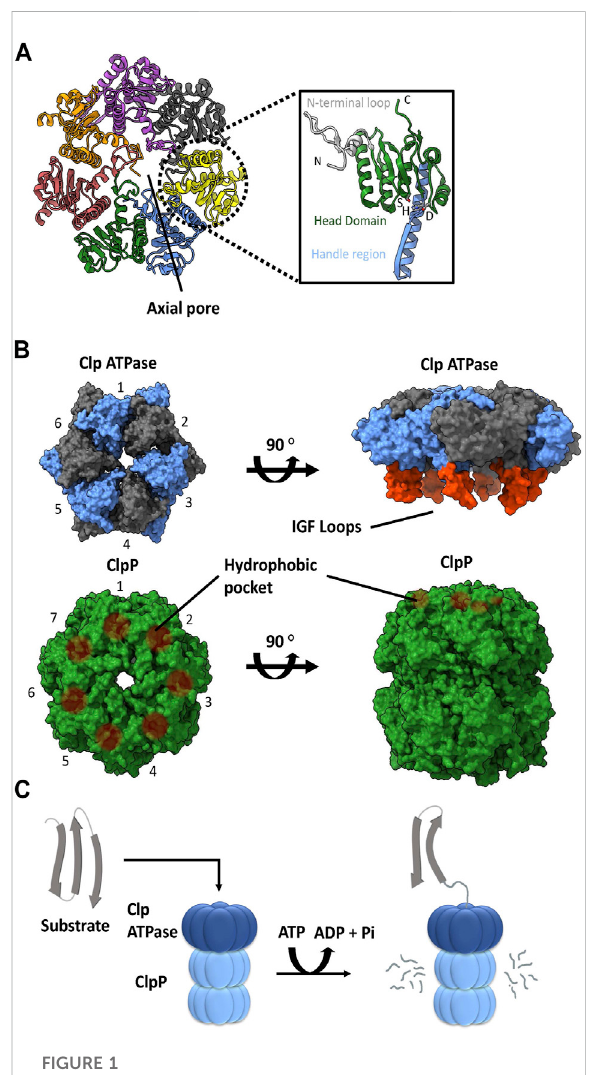
FIGURE 1 ClpP and Clp ATPases general architecture. (A) Top view of the E. coli ClpP cylinder (PDB ID: 1YG6). In the illustration on the right, the N-terminal loop (silver), head domain (green), handle region(blue)andcatalytictriad(S,H,D)oftheClpPmonomer are indicated (PDB ID 1YG6). (B) The association of a Clp ATPase hexamer (PDB ID 6SFW) with a ClpP tetradecamer (PDB ID 6SFX). Clp ATPase subunits (blue and grey) with their corresponding IGF loops (orange) are shown. ClpP subunits (green) and their hydrophobic pockets are denoted as brown circles. (C) General schematic of the proteolytic degradation cycle mediated by ClpP with its cognate Clp ATPase. Substrates are unfolded by the Clp ATPase and then translocated in an ATP-dependent manner into the ClpP catalytic chamber for